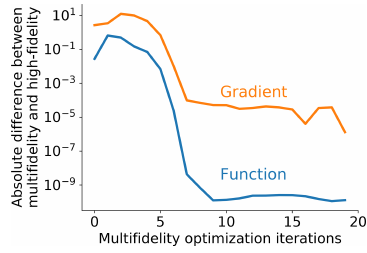
Figure 3. Both the function and gradient values of the multifidelity approximation converge to the high-fidelity values for the 1D ex-